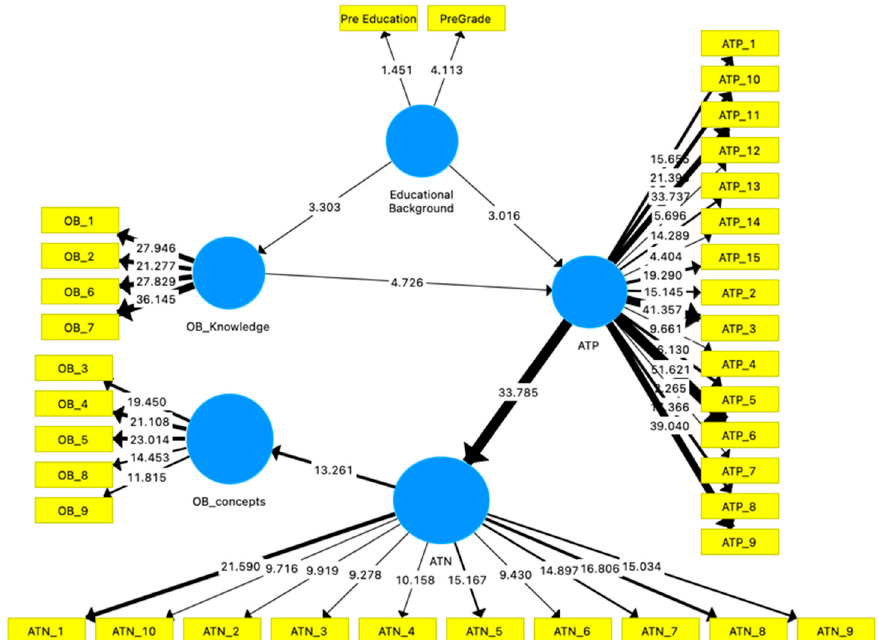
Figure 6. Results of the relation between the studied variables after applying the structural equation modeling—partial least squares (SEM-PLS) analysis and t-values are showed for the inner and outer model. Paths have been highlighted based on relative values.